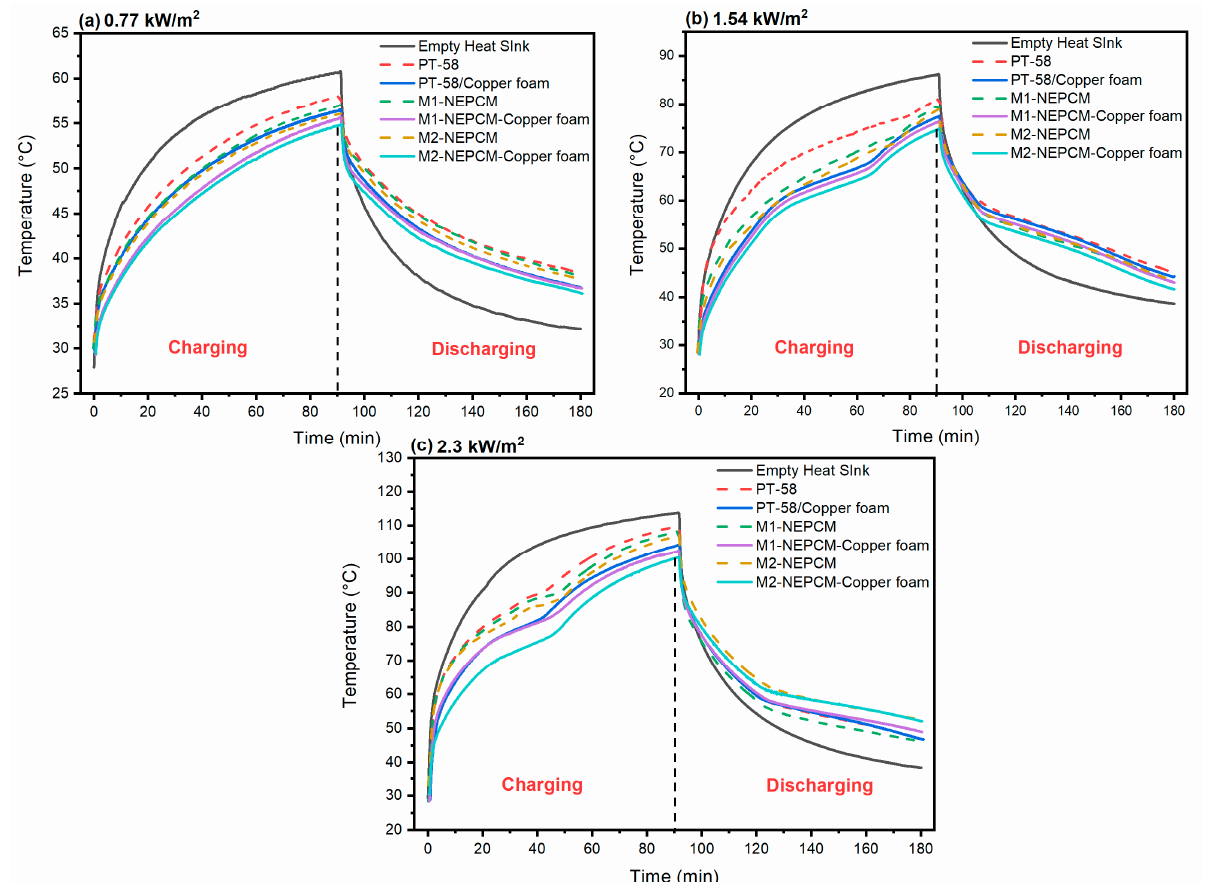
Figure 14. Charging and discharging analysis of various configurations of MgO/PCM composites at heating inputs of: ( a ) 0.77 kW/m 2 ; ( b ) 1.54 kW/m 2 ; ( c ) 2.3 kW/m 2